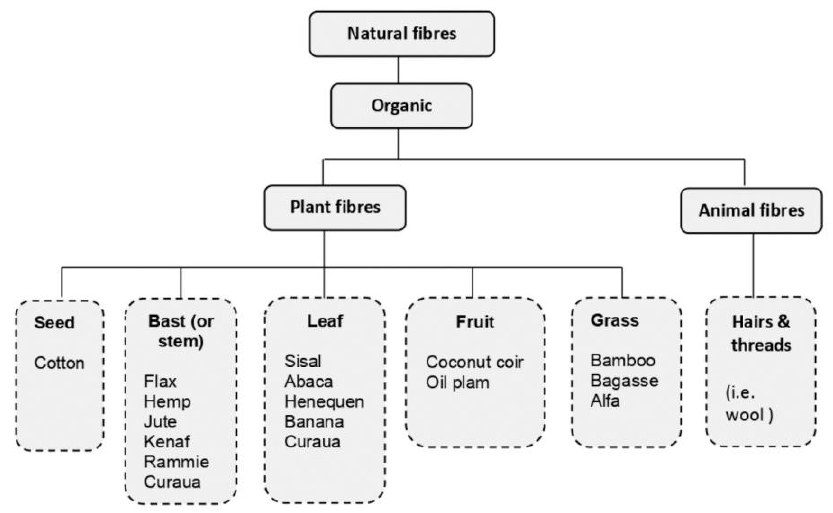
Figure 16. Classification of natural fibers [90].